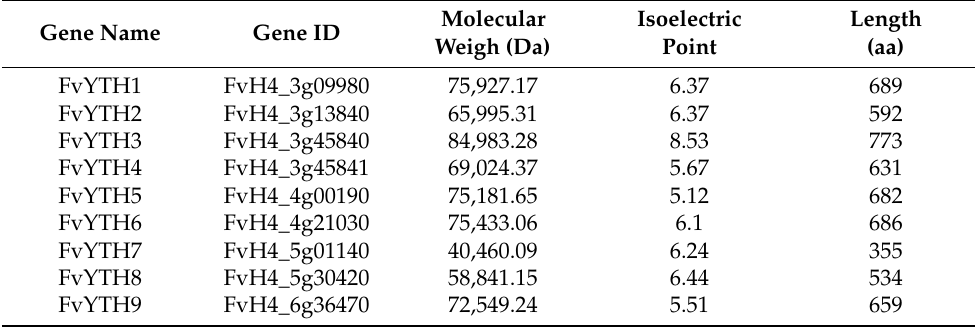
Table 1. Protein properties of YTH proteins in